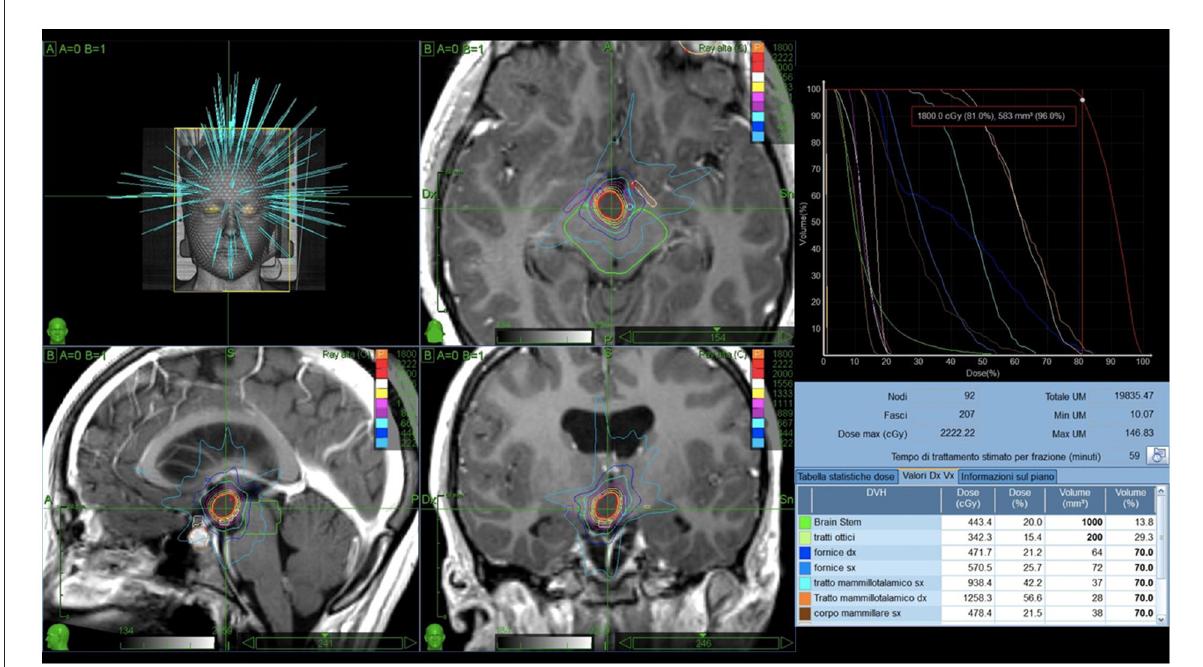
FIGURE1 Example of treatment plan. A 3D simulation of the beams pathway delivering 18Gy prescribed to the 81% isodose and the isodose curves on axial, sagittal and coronal T1-weighted scans are reported in (A) . (B) Shows the dose-volume histogram (DVH). Green: brainstem (443.4cGy, 20.0%). Light green: optic tracts (342.3cGy, 15.4%). Blue: right fornix (471.7cGy, 21.2%). Light blue: left fornix (570.5cGy, 25.7%). Azure: left mammillothalamic tract (938.4cGy, 42.2%). Orange: right mammillothalamic tract (1258.3cGy, 56.6%). Brown: left mammillary body (478.4cGy,